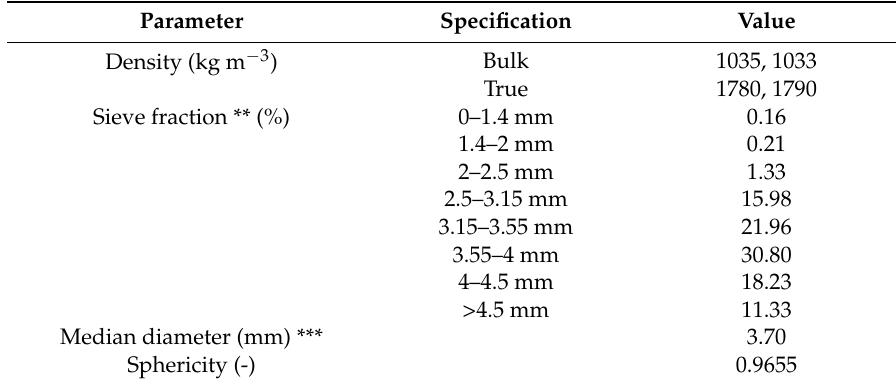
Table 1. List of fertilizer physical properties for CAN fertilizer * (ammonium nitrate 27% N + 4% MgO, Scoriethom) used in this experiment. True density was determined using gas pycnometry. For density, two replicates were used. Both the bulk and true density were determined.